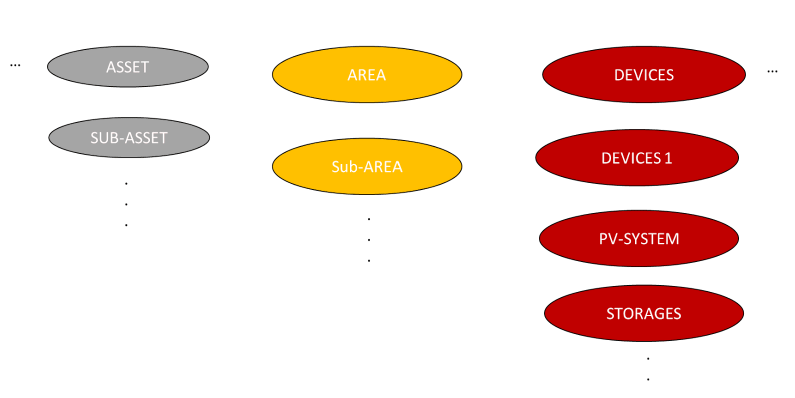
Figure 7. Topological Entities of Independent House.